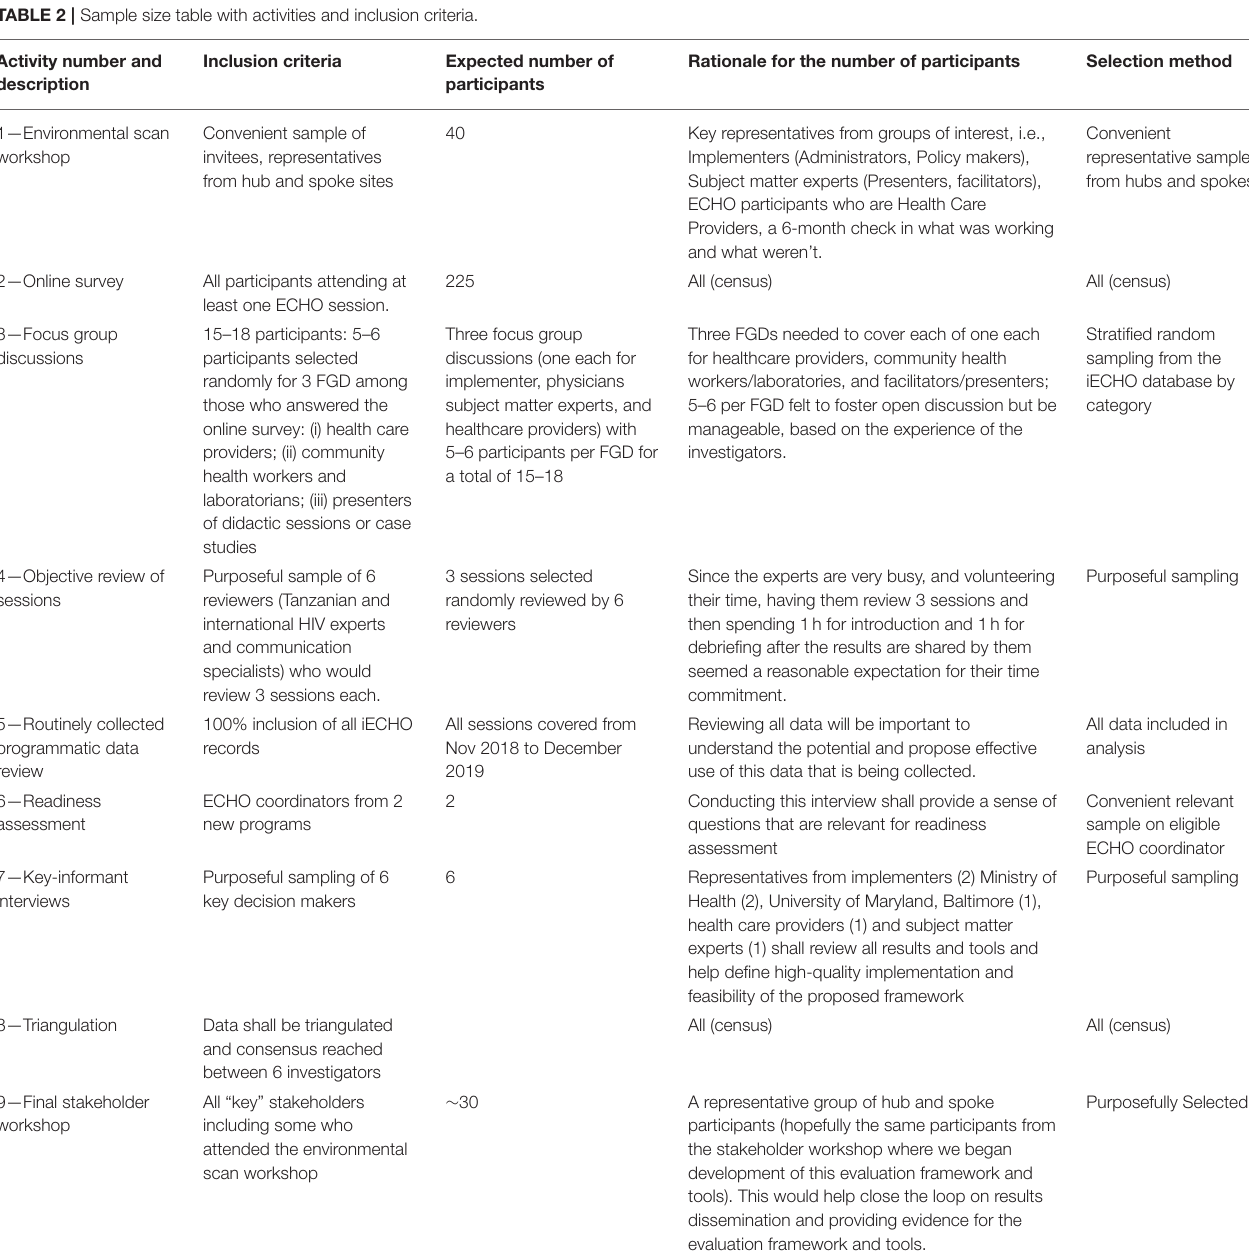
TABLE 2 | Sample size table with activities and inclusion